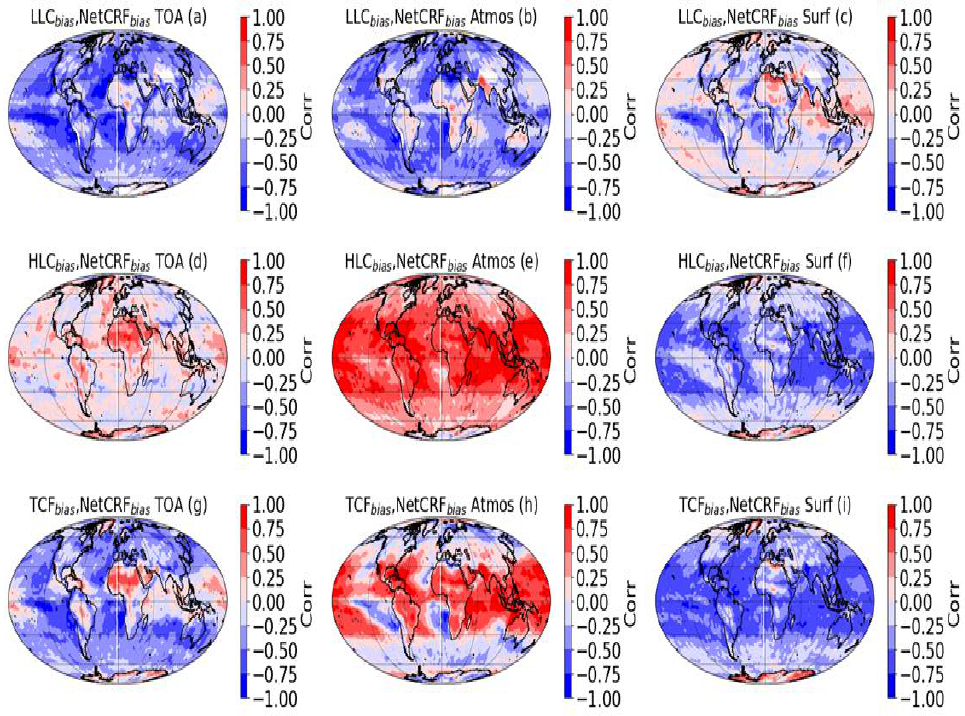
Figure 14. The global distribution of temporal (2006 – 2014) Pearson correlation of model bias in LLC, HLC, and TCF, and the bias in NetCRF TOA ( a , d , g ), atmosphere ( b , e , h ), and surface ( c , f , i ).